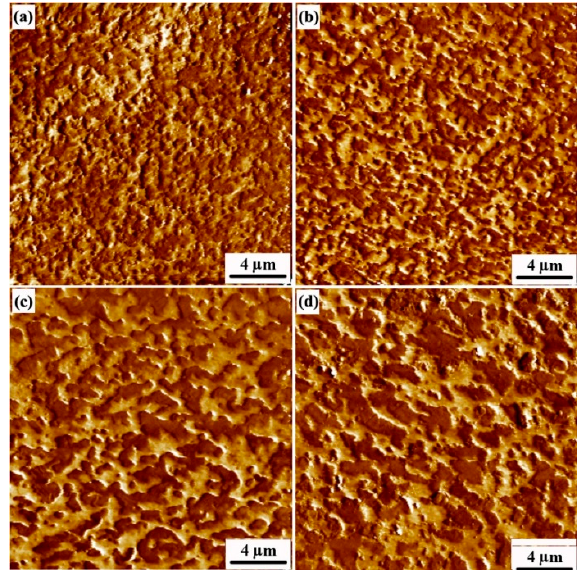
Figure 2. AFM phase images of EPDM/PP (60/40) TPV samples taken at different DV times: (a)–(d) represent the AFM images of samples A–D, respectively. (The lighter and darker regions represent the PP and EPDM phases, respectively). Table 1. Rubber particle sizes and size distributions of TPV samples.